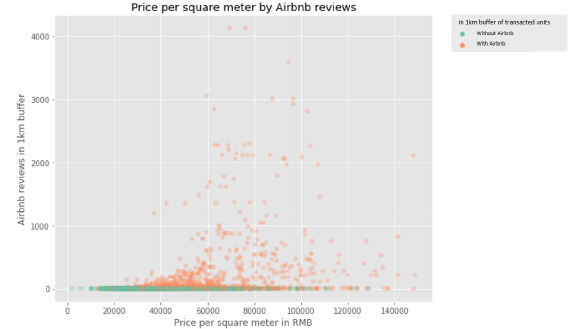
Figure 6. Number of Airbnb review in 1km buffer against unit resale